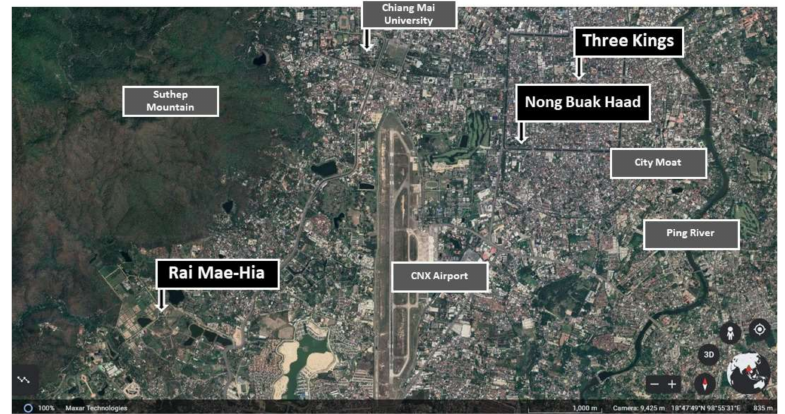
Figure 1. The location of the three study